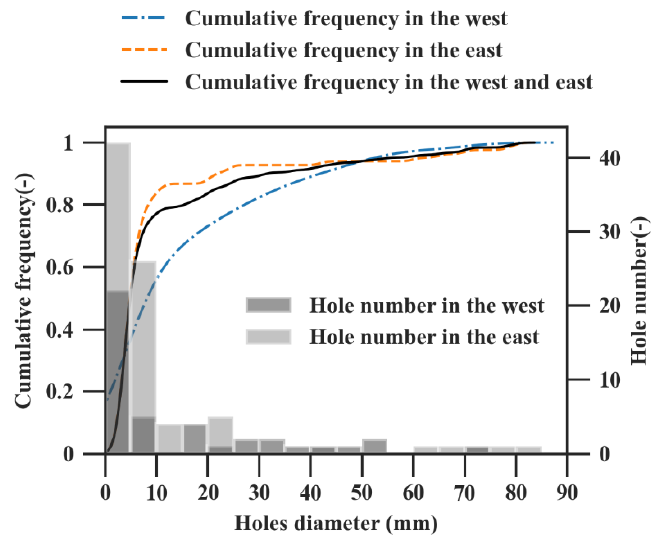
Figure 3. The number of holes with different diameters in the geomembrane and their cumulative frequency.